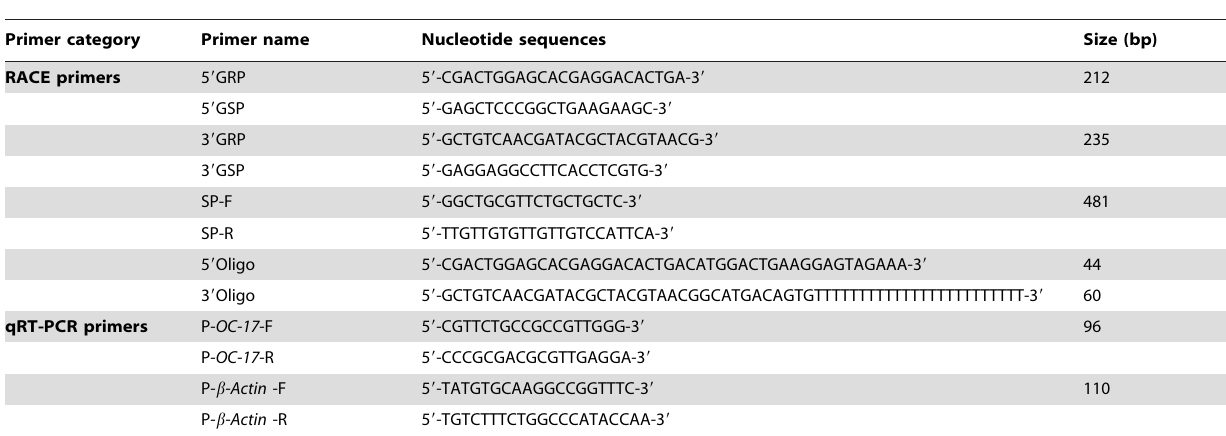
Table 1. Primers for amplifying cDNA and quantifying mRNA of